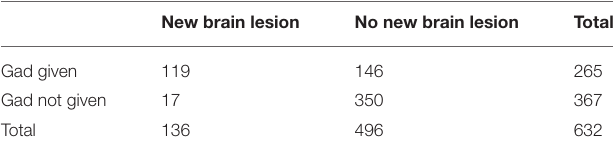
TABLE 2 | GBCA reduction initiative: results from the 3 month follow up validation